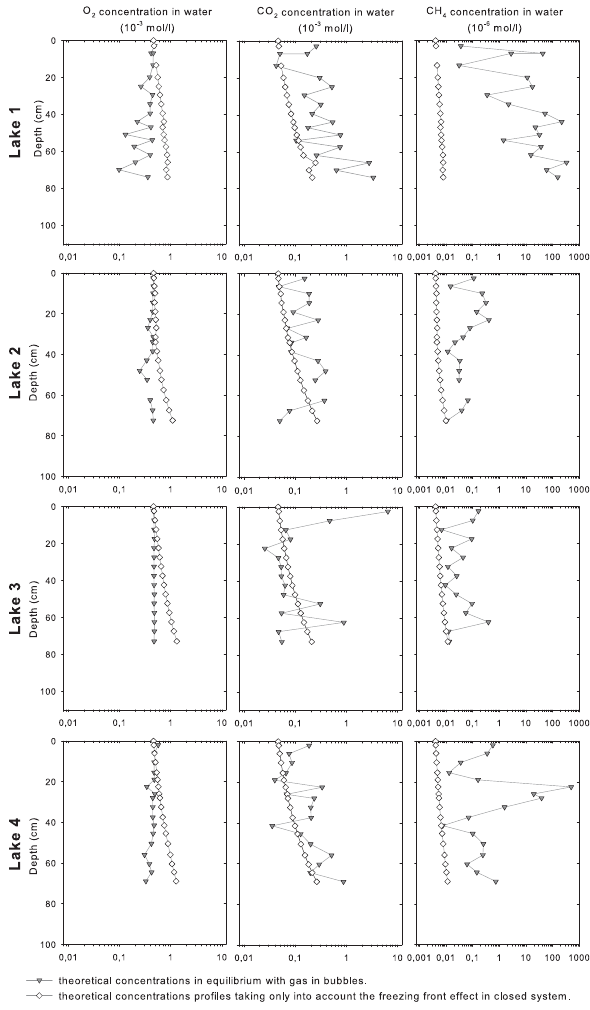
Fig. 7. Theoretical O 2 , CO 2 and CH 4 concentrations in water as a function of depth for each lake: triangles represent values in equilib- rium with measured gas mixing ratios in bubbles (calculated using Henry’s law); diamonds show theoretical values calculated by only taking into account the “reservoir effect” in a closed system (see text for details).